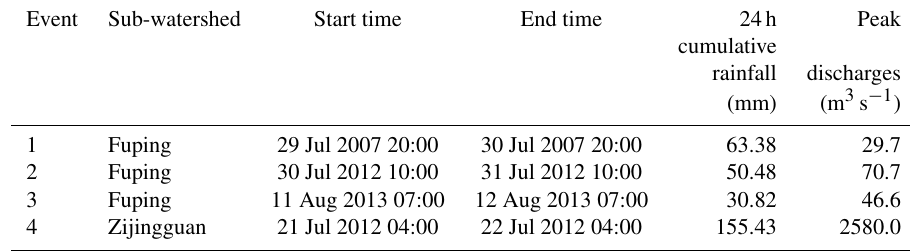
Table 2. Four 24h storm events selected from the study site. Event